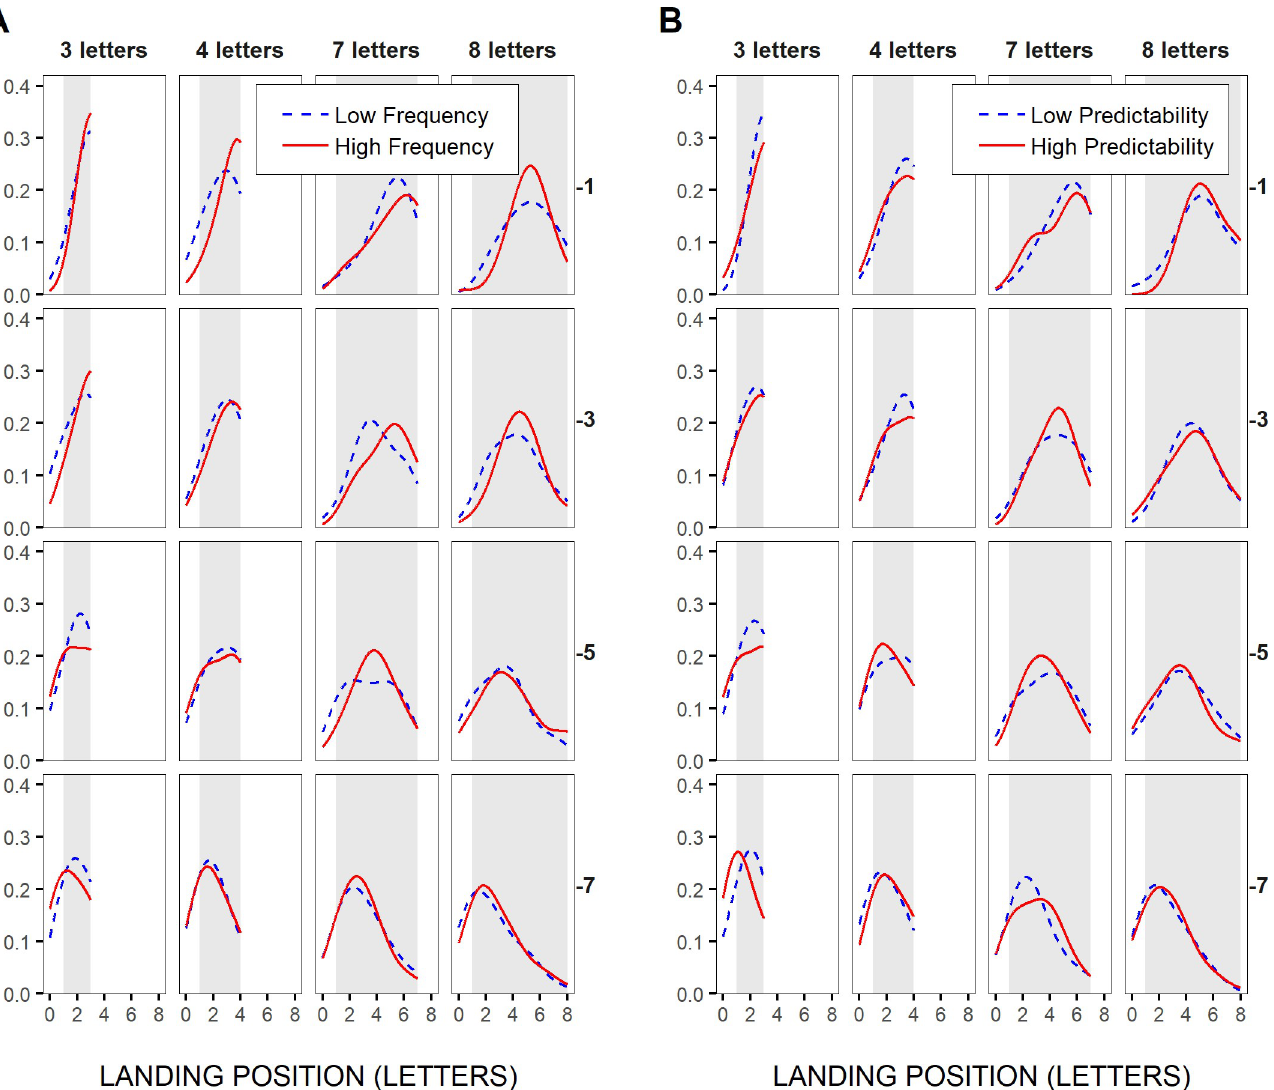
Fig 7. Distributions of initial landing positions in the test words. Across-participants probability density functions (bandwidth: 1 letter or 0.25˚; Gaussian Kernel) of initial landing positions in short and long test words (3–4 letters and 7–8 letters in left and right panels respectively), for different saccadic launch-site distances (in letters relative to the space in front of the test words), binned in two-letter intervals (from upper to lower panels: [0,-2[, [-2,-4[, [-4,-6[, [-6,-8[, referred to as -1,-3,-5 and -7 respectively), and separately for the two most extreme categories of word frequencies (A) and of word predictabilities (B), when these were grouped respectively into four bins (see Materials and Methods). Light-grey rectangle areas represent the horizontal extent of the